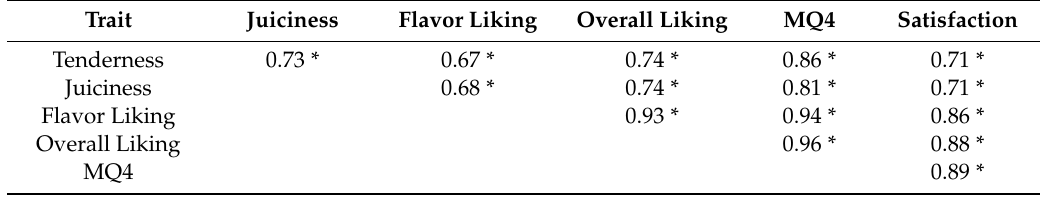
Table 4. Pearson’s correlation coe ffi cients for the relationships between consumer sensory scores of longissimus lumborum aged 21 to 84 days